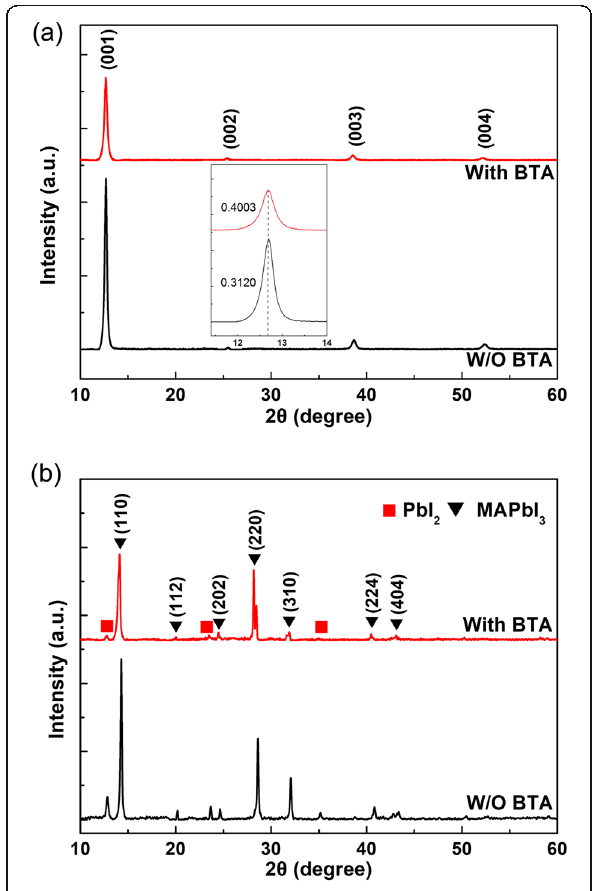
Fig. 4 XRD spectra of PbI 2 films ( a ) and MAPbI 3 films ( b ) on quartz substrates prepared with and without BTA additive, in ambient air under 25% RH. The inset of ( a ) is the rocking curve of the main diffraction peak of PbI 2 films at